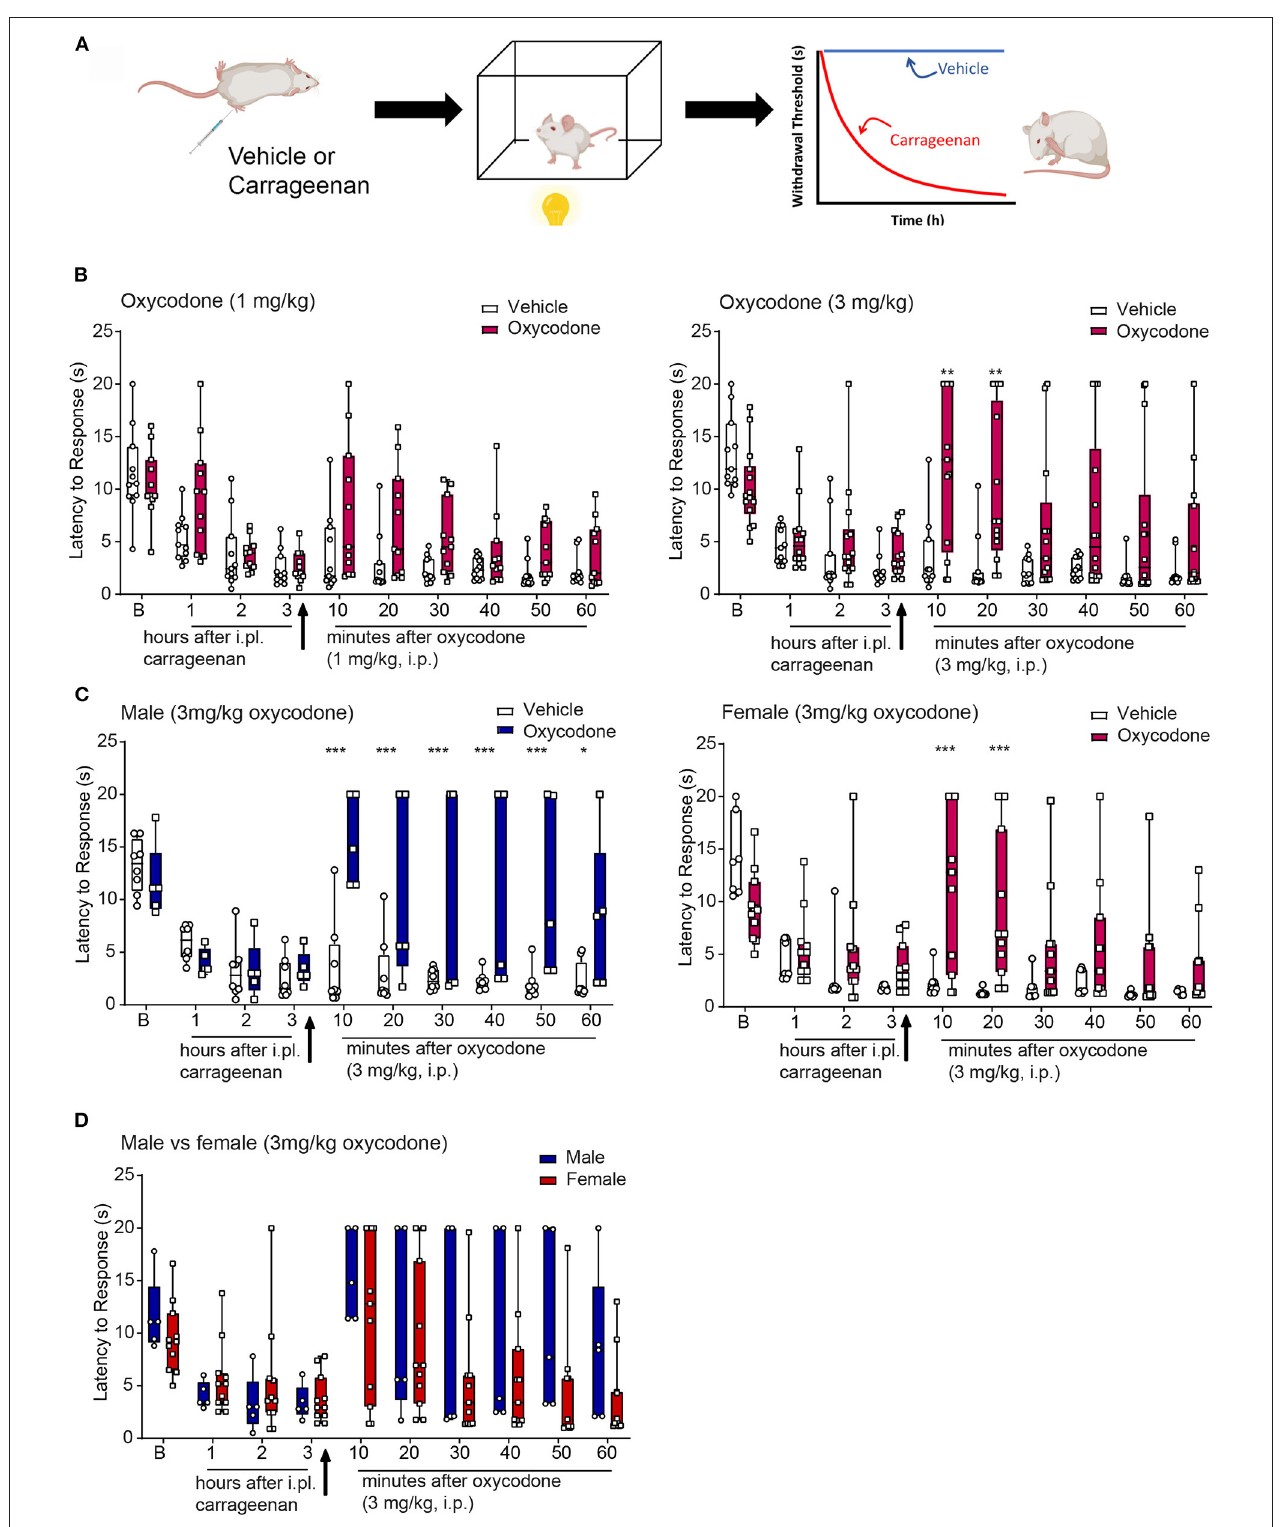
FIGURE 6 | Anti-hyperalgesic effects of oxycodone in the thermal plantar test following intra-plantar (i.pl.) injection of carrageenan. (A) Schematic image of a protocol. Mice received an i.pl. injection of carrageenan (2%) into the left hindpaw. Baseline latencies were acquired prior to injection and mice were tested once in an h for